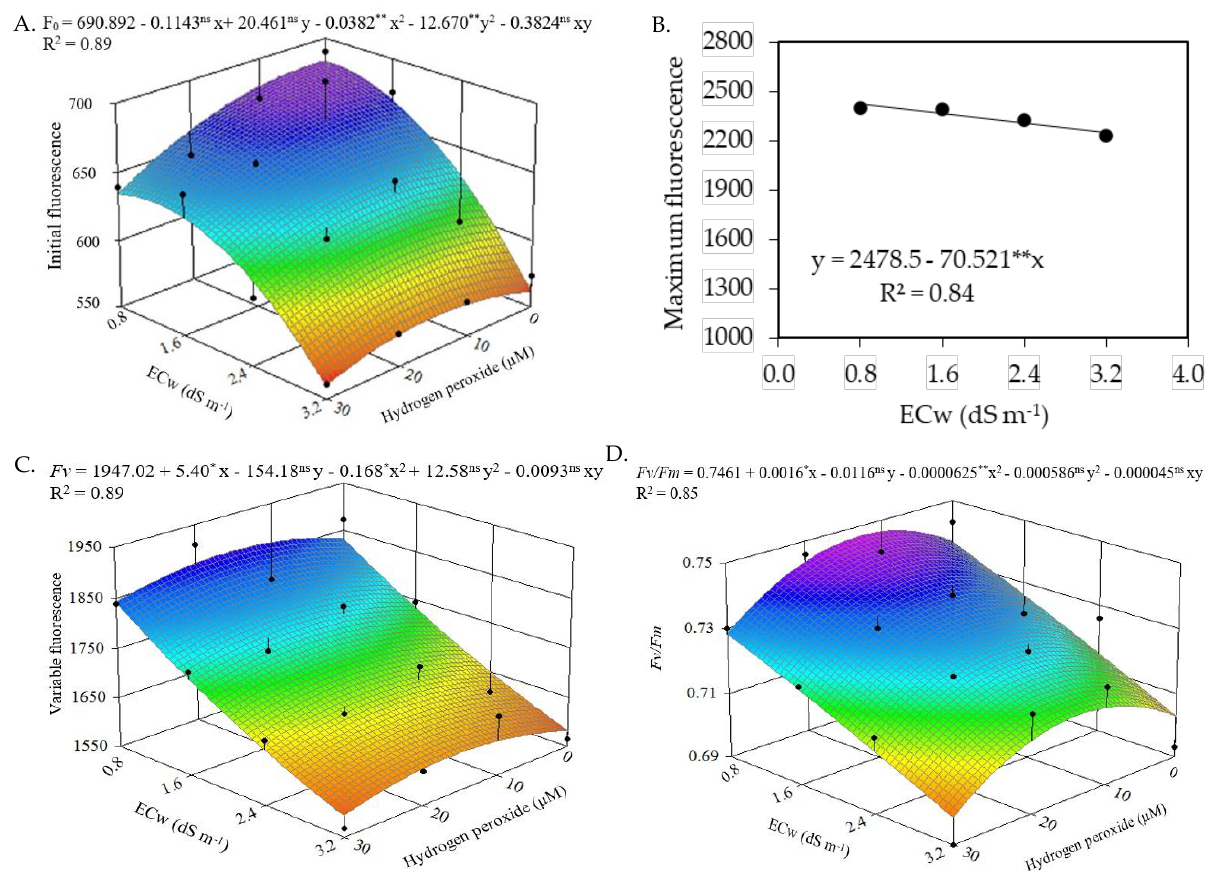
Figure 3. Initial fluorescence ( F 0) ( A ), variable fluorescence ( Fv ) ( C ), and quantum efficiency of photosystem II ( Fv / Fm ) ( D ) of soursop plants cv. Morada Nova as a function of the interaction between the salinity levels of irrigation water (ECw) and hydrogen peroxide concentrations, and maximum fluorescence ( Fm ) ( B ) as a function of the irrigation water salinity (ECw) at 210 days after transplantation. ns, * and ** are, respectively, not significant and significant at p ≤ 0.05 and ≤ 0.01 by the F-test. x and y correspond to ECw and hydrogen peroxide (H 2 O 2 ) concentrations, respectively.